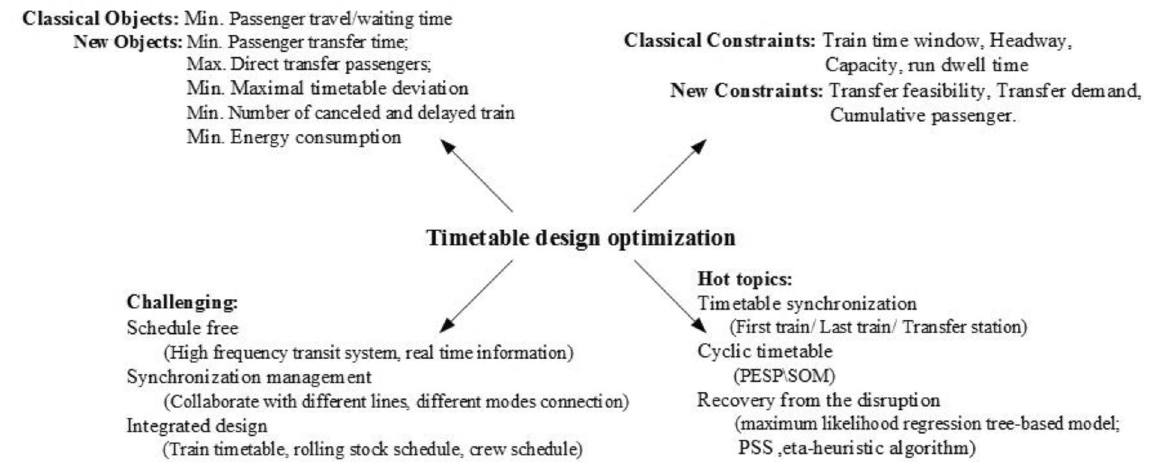
Fig. 4 Objects, constraints hot topic, and challenges in timetable design